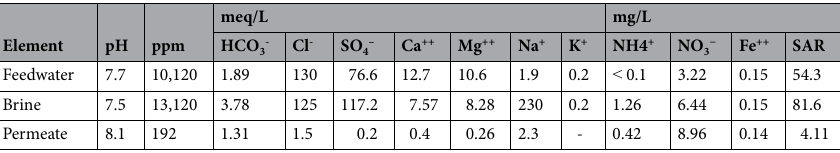
Table 2. Chemical properties of water samples used. SAR Sodium adsorption ratio, HCO 3 − hydrogen carbonate ions, SO 4 – sulfate ions, Cl − chloride ions, Ca ++ calcium ions, Mg ++ magnesium ions, Na + sodium ions, K + potassium ions, Fe ++ ferric, NH 4 + ammonium ions, NO 3 −